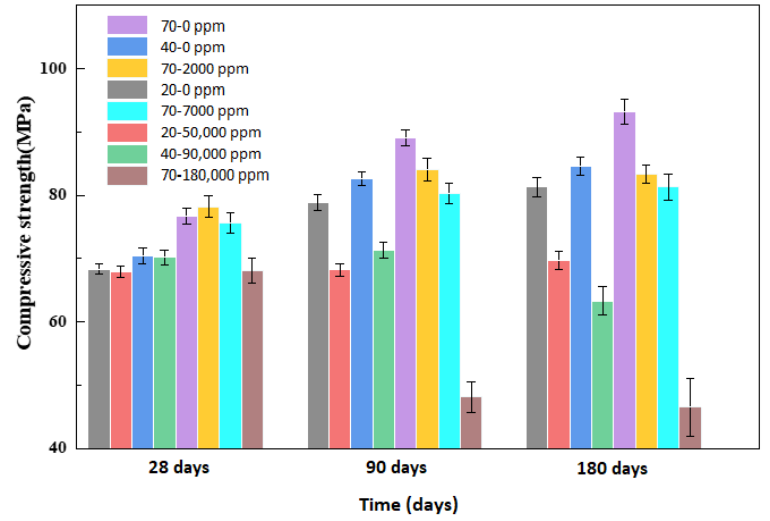
Figure 5. Compressive strength of the concrete samples at different ages.